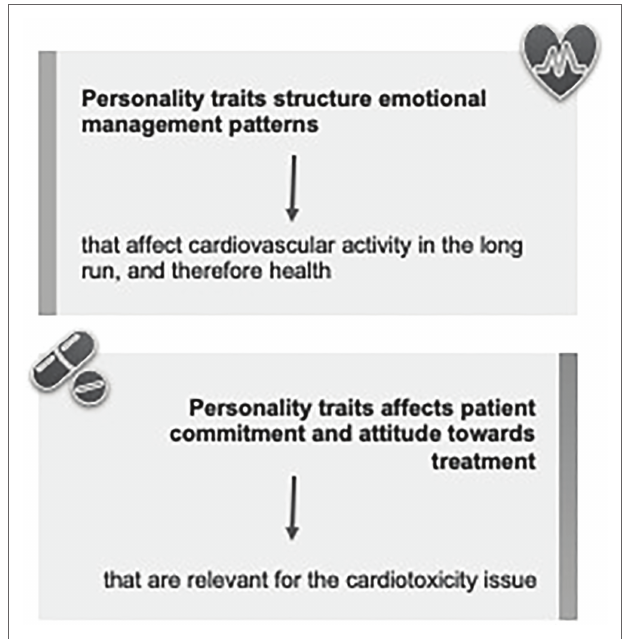
FIGURE 1 | A schematic description of the role of personality traits in emotional regulation and health